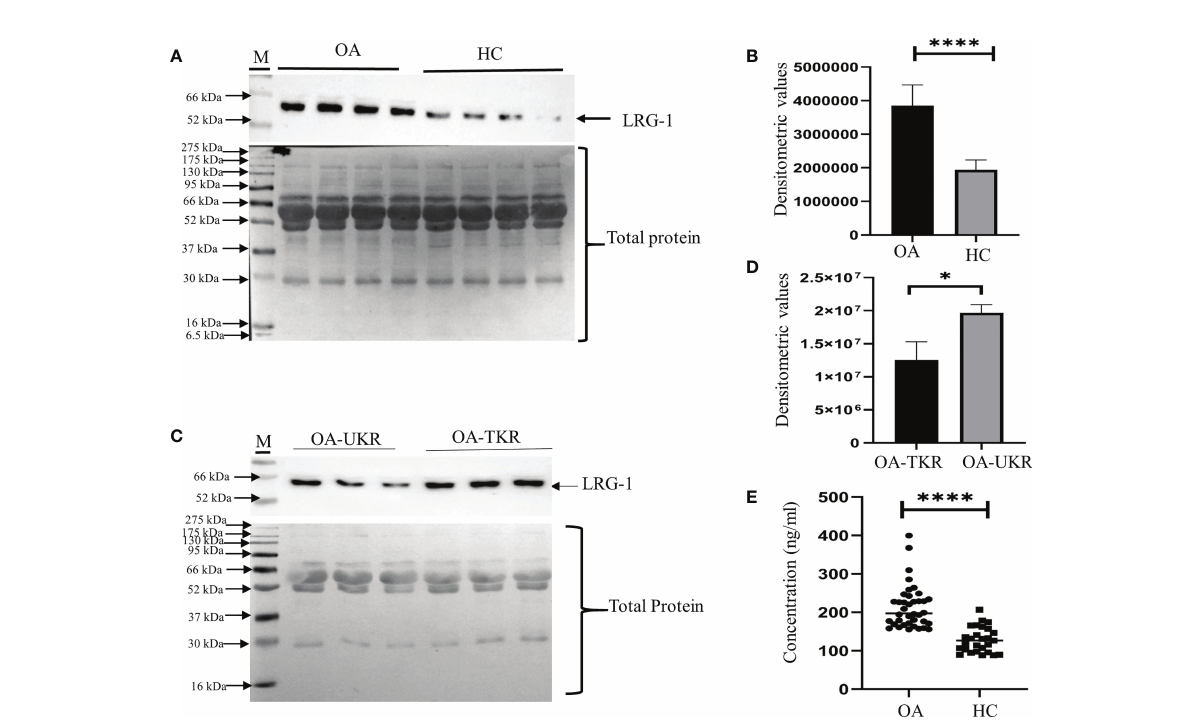
FIGURE 1 Validation of LRG1 by Western blot (WB). WB images were taken by Chemidoc (Bio-Rad, Hercules, CA, USA), and densitometry analysis of all WB images was carried out using Image Lab v6 (Bio-Rad). All graphs were generated and the statistical analysis carried out using GraphPad Prism (version 8.4.686). Data are presented as the mean ± standard deviation (SD). Paired Student ’ s t -test was performed for group comparisons in (B, D, E) to show statistical signi fi cance. (A) WB image of the expression of LRG1 in pooled plasma samples from patients with OA and from HCs ( upper panel ) and Ponceau staining of blots showing total protein as the loading control ( lower panel ). (B) Graph of the densitometric analysis of the WB images using Image Lab software. LRG1 was found to be 2.3-fold upregulated in the plasma samples from OA patients compared to those from HCs. (C) WB images of the LRG1 expression and Ponceau staining of blots showing total protein in the SF samples from patients who had TKR compared to those who had UKR. (D) Bar graph showing the 1.6-fold upregulation of LRG1 in SF samples ( p = 0.015). (E) ELISA results showing the concentrations of LRG1 in plasma samples from patients with OA compared to those from HCs. The fold change was 1.66 in OA compared to HC plasma. * p ≤ 0.05; **** p ≤ 0.0001. ns , non-signi fi cant; LRG1 , leucine-rich alpha-2 glycoprotein; OA , osteoarthritis; SF , synovial fl uid; HC , healthy control; TKR , total knee replacement; UKR , unicompartmental knee